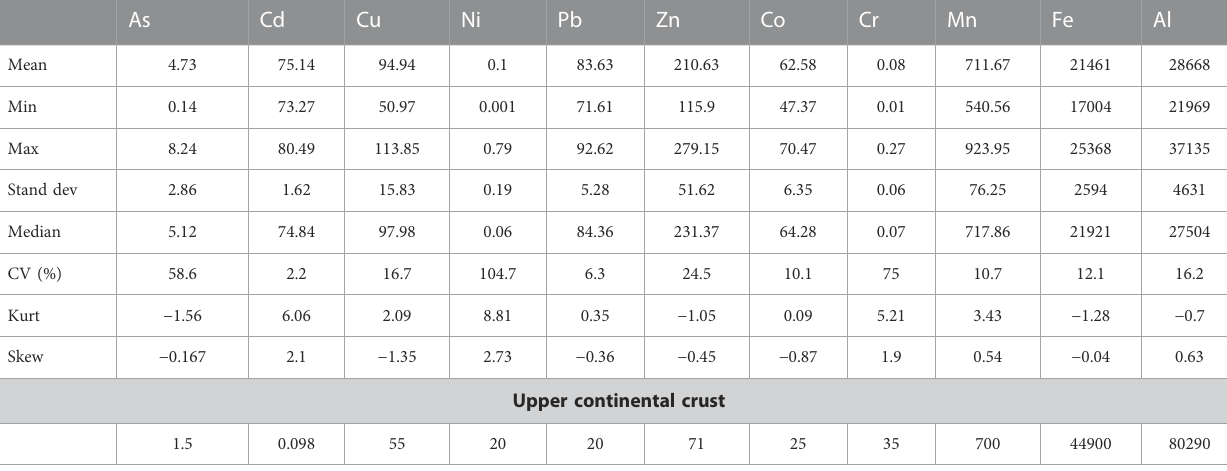
TABLE 2 Basic statistics of the metal contents of road dust obtained from the Abu Dhabi-Liwa Highway (mg/kg). As